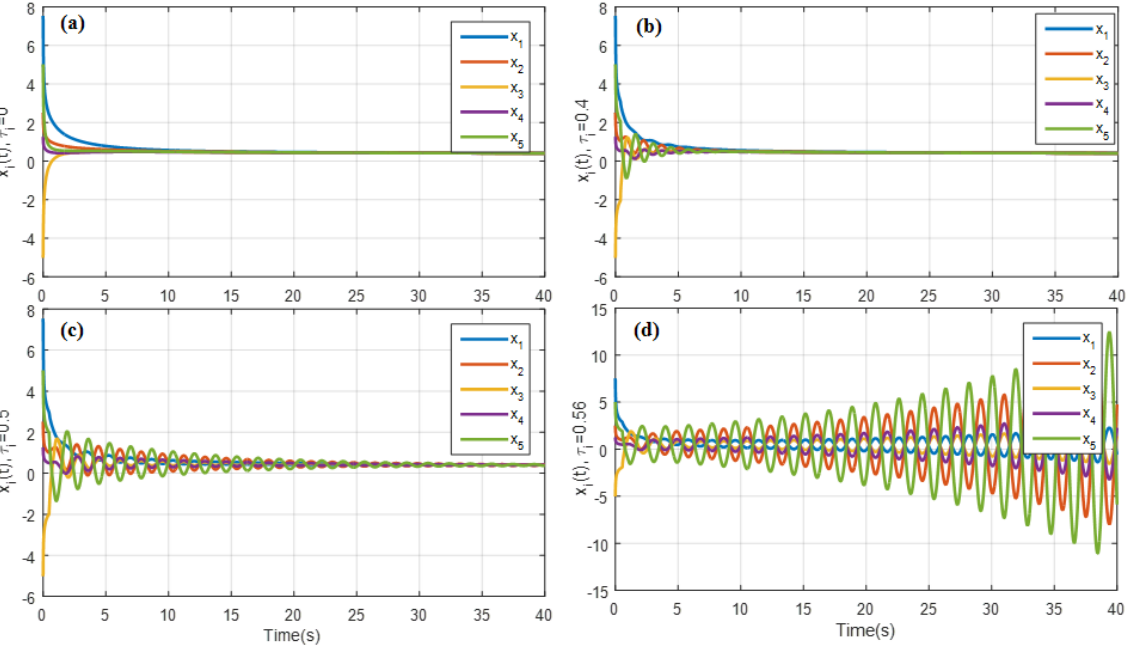
Figure 8. Trajectories of agents in the numerical example of Section IV for different time delays. ( a )